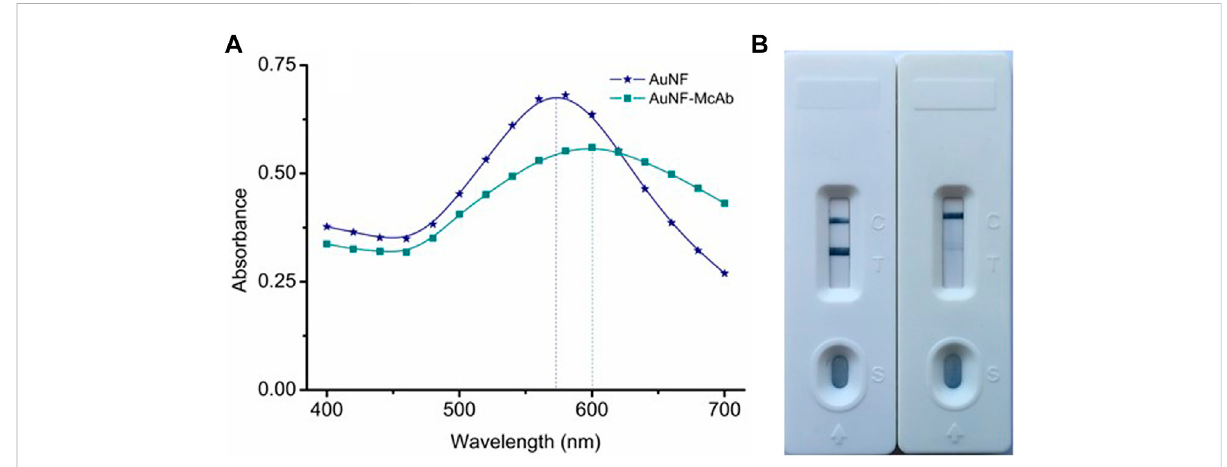
FIGURE 5 Preparation andidenti fi cationofAuNF-basedprobe. (A) UV-VIS spectrumscanningoftheAuNF-McAb conjugate. (B) The activity identi fi cation of AuNF-McAb